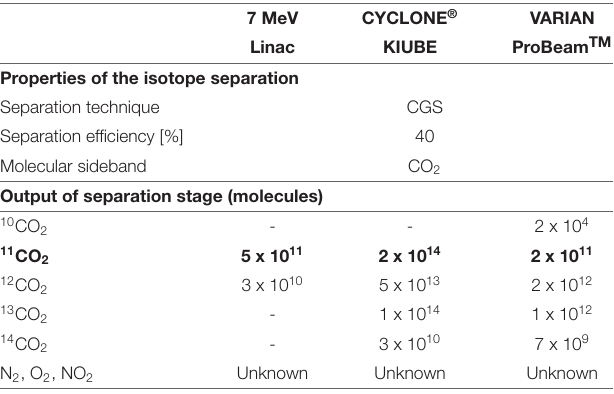
TABLE 3 | Gas output (molecules per batch) after separation stage for an N 2 target: 11 C molecular compounds (in bold) and the corresponding impurities.